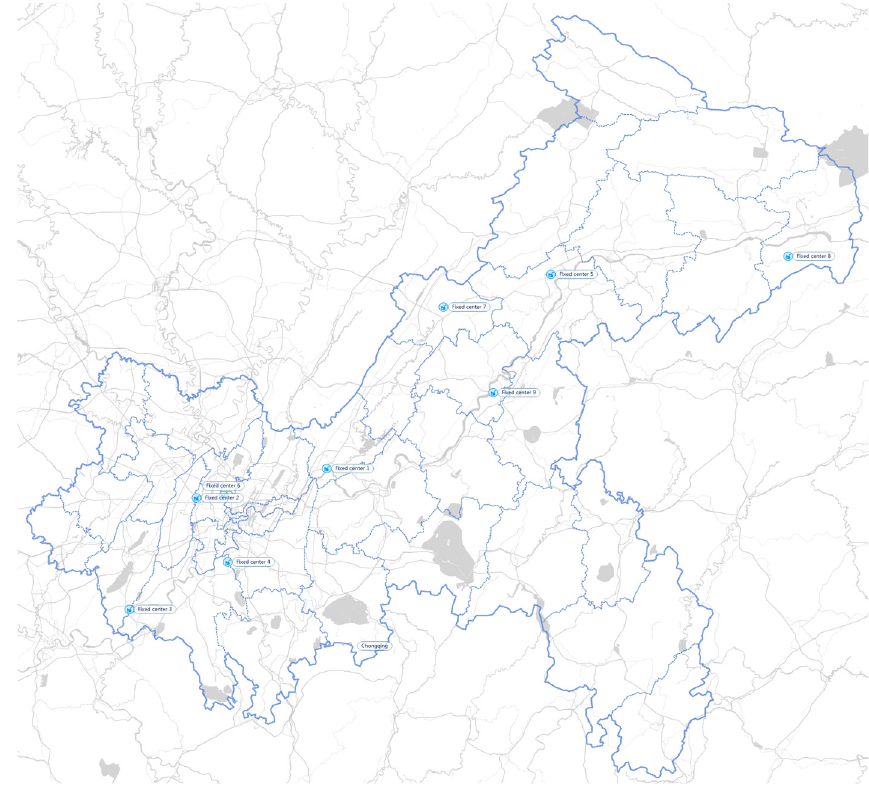
Figure 5. FPCs in Chongqing.